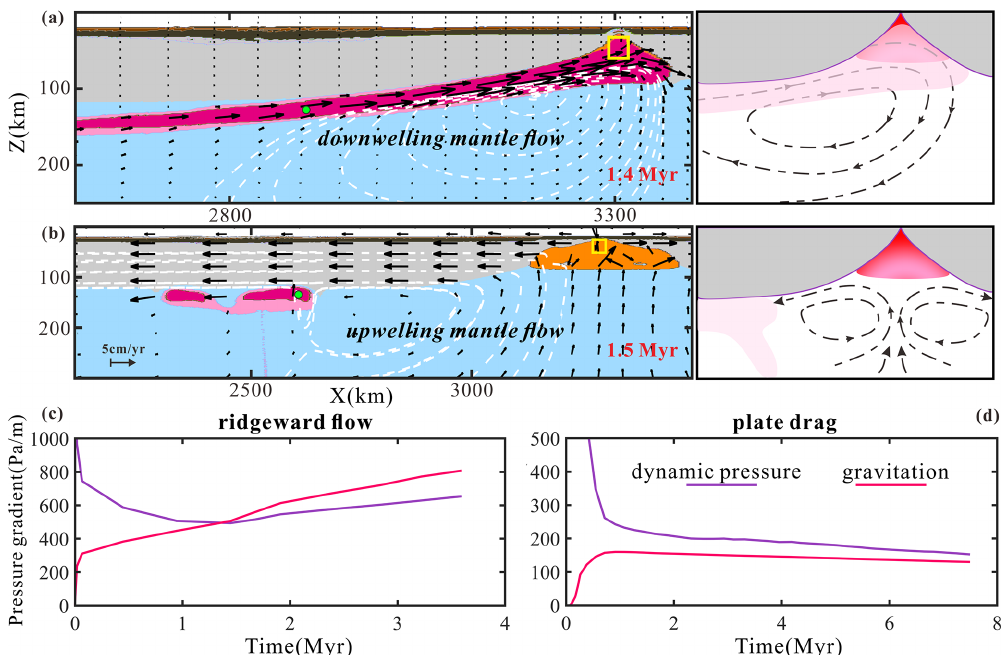
Figure 5. Comparison between models with ridgeward vs. plate-drag plume flow. (a) Ridgeward flow with downwelling beneath the MOR (results from case M12, as in Fig. 3). Dashed white lines are streamlines; black arrows visualize the flow field. A schematic of flow is in the sub-panel on the right-hand side. (b) Plate-drag flow with upwelling mantle corner flow beneath the MOR (results from case M77, as in Fig. 4). (c) The dynamic-pressure and gravitational gradient of the plume marker (i.e., green circle in a ) over time. (d) The dynamic-pressure and gravitational gradient of the plume marker (i.e., green circle in b ) over time. The yellow box marks the location for the computation of average dynamic pressure at the ridge, needed for the calculation of the dynamic-pressure gradient (see text). The (c) and (d) represent the results of ridgeward and plate-drag flow,